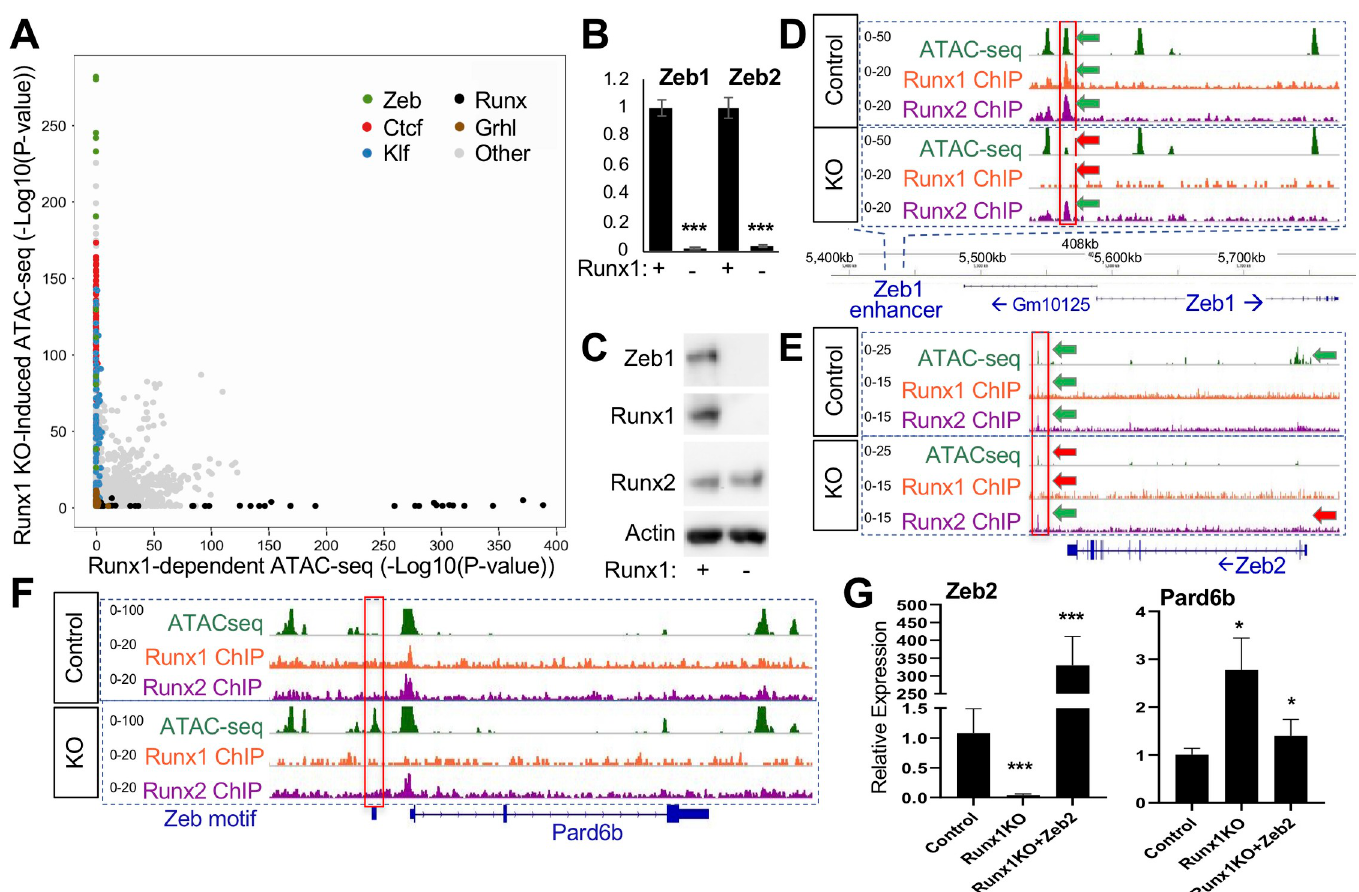
Fig 4. Runx1KO Cells Lack Zeb Repressors, Leading to the Opening of Chromatin. A) Graph displaying p-values of transcription factor motif enrichment in Runx1-dependent versus Runx1-induced ATAC-seq, revealing that Zeb motifs are specifically enriched in Runx1KO-Induced ATAC-seq peaks. Additionally, Ctcf, Klf, and Grhl motifs are enriched in the Runx1KO-induced ATAC-seq peaks, while Runx motifs are enriched in the Runx1-dependent ATAC-seq. Note that this graph has had AP-1 motif enrichment results removed in order to focus on other motif enrichment levels (see S6A Fig for all transcription factor motifs). B) RT-qPCR showing that Runx1KO cells lose expression of Zeb1 and Zeb2. C) Western blot showing the absence of the Zeb1 protein in Runx1KO cells. D) Genomic snapshot showing a chromatin region near Zeb1 that is bound by Runx1 and Runx2 and loses chromatin accessibility in Runx1KO cells. E) Genomic snapshot of the Zeb2 locus showing a downstream potential enhancer bound by Runx1 and Runx2 that has decreased chromatin accessibility along with a loss of expression in Runx1KO cells. F) Genomic snapshot of the Zeb target gene Pard6b locus showing a promoter region containing a predicted Zeb binding site that is specifically open in Runx1KO cells. G) RT-qPCR showing that Zeb2 transient transfection of Runx1KO cells induces repression of Pard6b expression down to levels similar to those in control cells after 1 day of selection for transfected cells followed by 2 days of growth in media. ( � = p-value < 0.05, �� = p < 0.005; ��� = p-value < 0.0005).